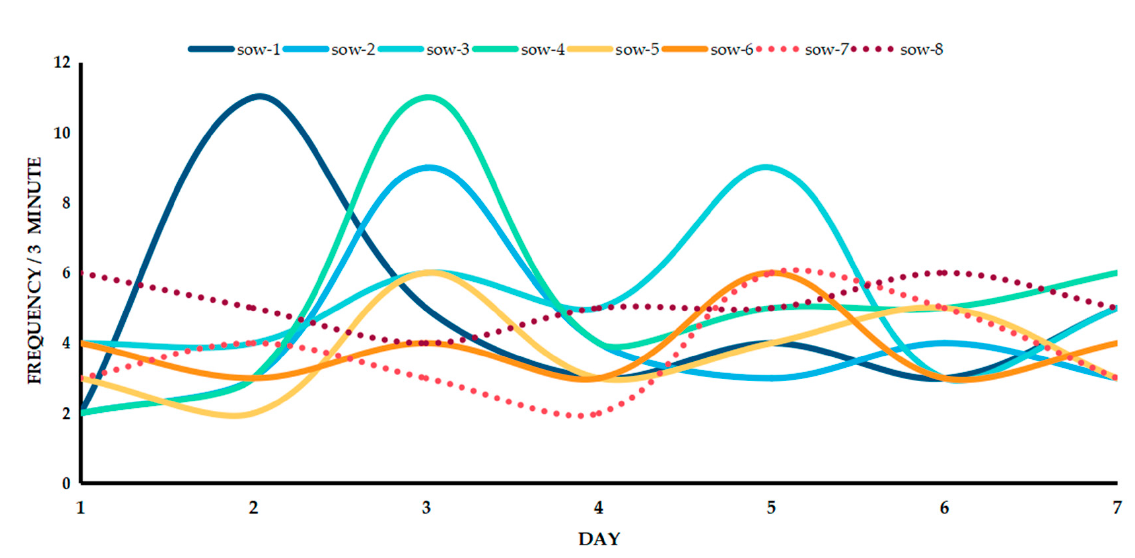
Figure 7. The number of times the sow was in contact with the bionic boar 1–7 days after weaning (within three minutes of a single love check).